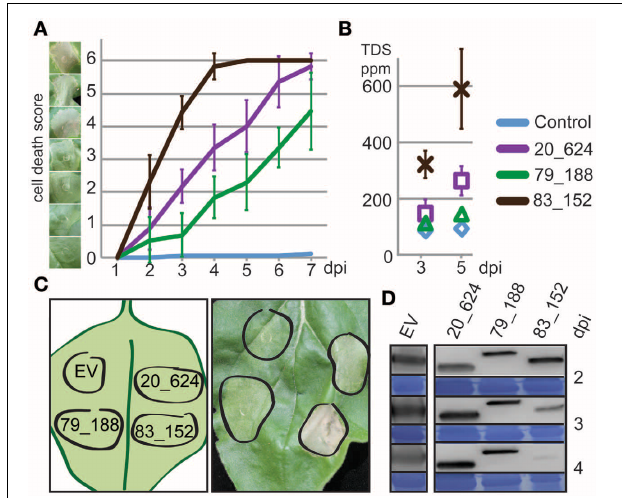
FIGURE 2 | Necrosis inducing CRNs show distinct cell death inducing dynamics. (A) Progression of cell death in N. benthamiana leaves infiltrated with CRNs. Cell death was scored every 24h on a scale of 0–6. Example lesions for each score are shown on the left. The graph shows average values ± standard deviation for one representative experiment. (B) Ion leakage measurements confirming differences in cell death response. Each data point is an average of 6 measurements ± standard deviation. TDS ppm: total dissolved solids in parts per million. (C) Graphical representation of the experimental set-up (left) and a typical leaf 4 days post inoculation. (D) Western blots and loading control for CRNs and control samples showing protein levels up to 4dpi. EV: GFP antibodies, CRNs: strepII